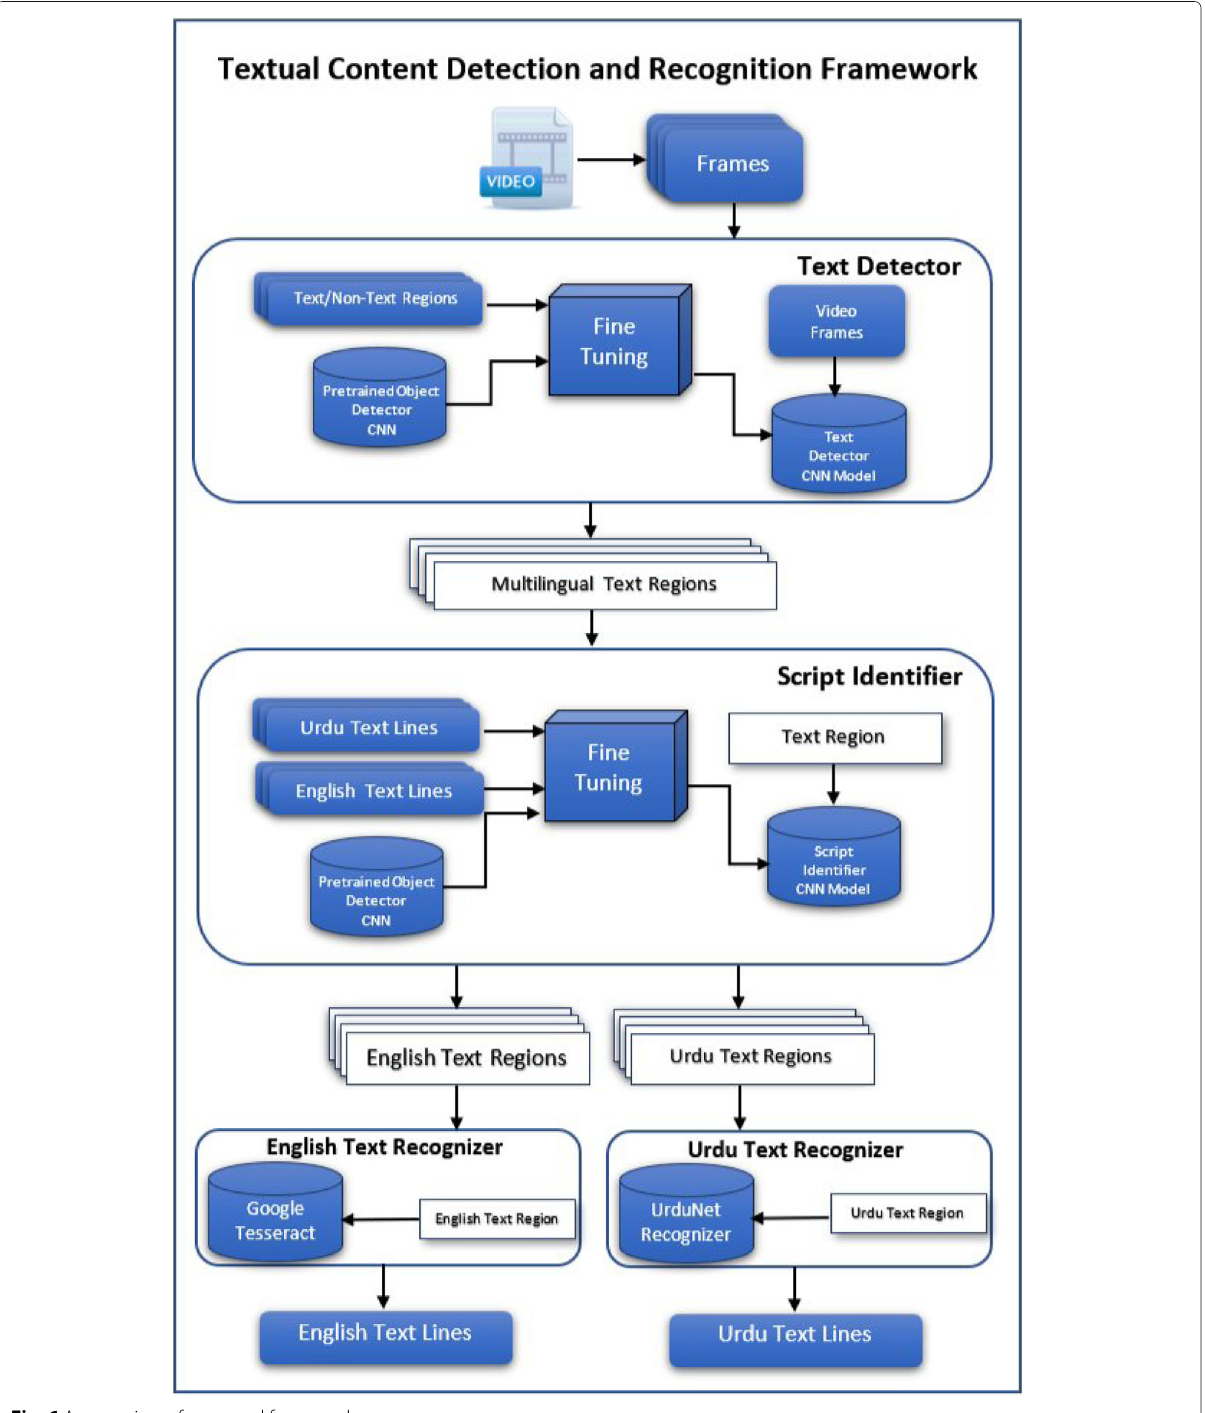
Fig. 6 An overview of proposed framework